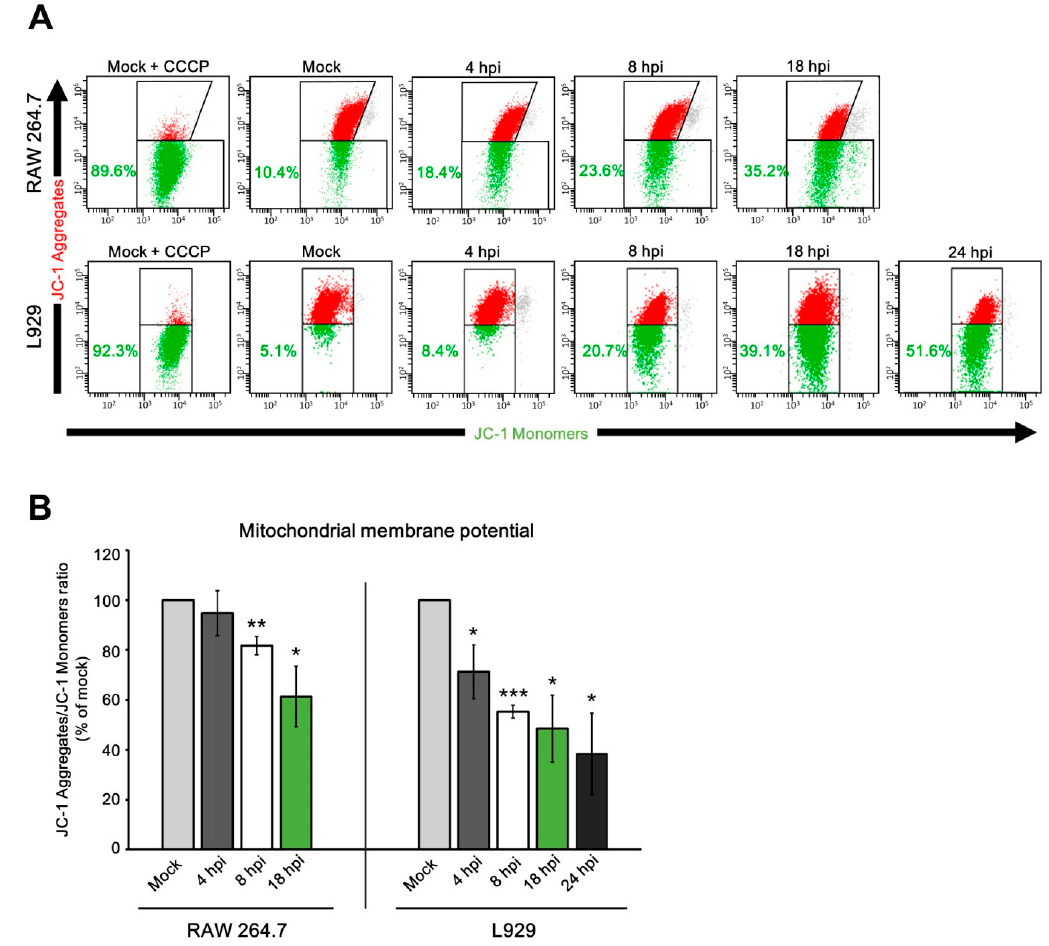
Figure 12. Mitochondrial membrane potential (MMP) in RAW 264.7 and L929 cells during ECTV infection. ( A ) Representative double fluorescence dot plots of flow cytometry analysis of 5,5 ′ ,6,6 ′ -tetrachloro-1,1 ′ ,3,3 ′ -tetraethylbenzimidazol-carbocyanine iodide (JC-1) staining in RAW 264.7 and L929 cells during ECTV infection. Red populations indicate cells with high MMP. Green populations indicate cells with depolarized MMP. ( B ) Mean JC-1 Aggregates/JC-1 Monomers ratio at 4, 8, and 18 hpi in RAW 264.7 macrophages and at 4, 8, 18, and 24 hpi in L929 fibroblasts. Data from three independent experiments are presented as mean ± SD ( n = 10,000 cells). Student’s t -test; * p ≤ 0.05; ** p ≤ 0.01; *** p ≤ 0.001.